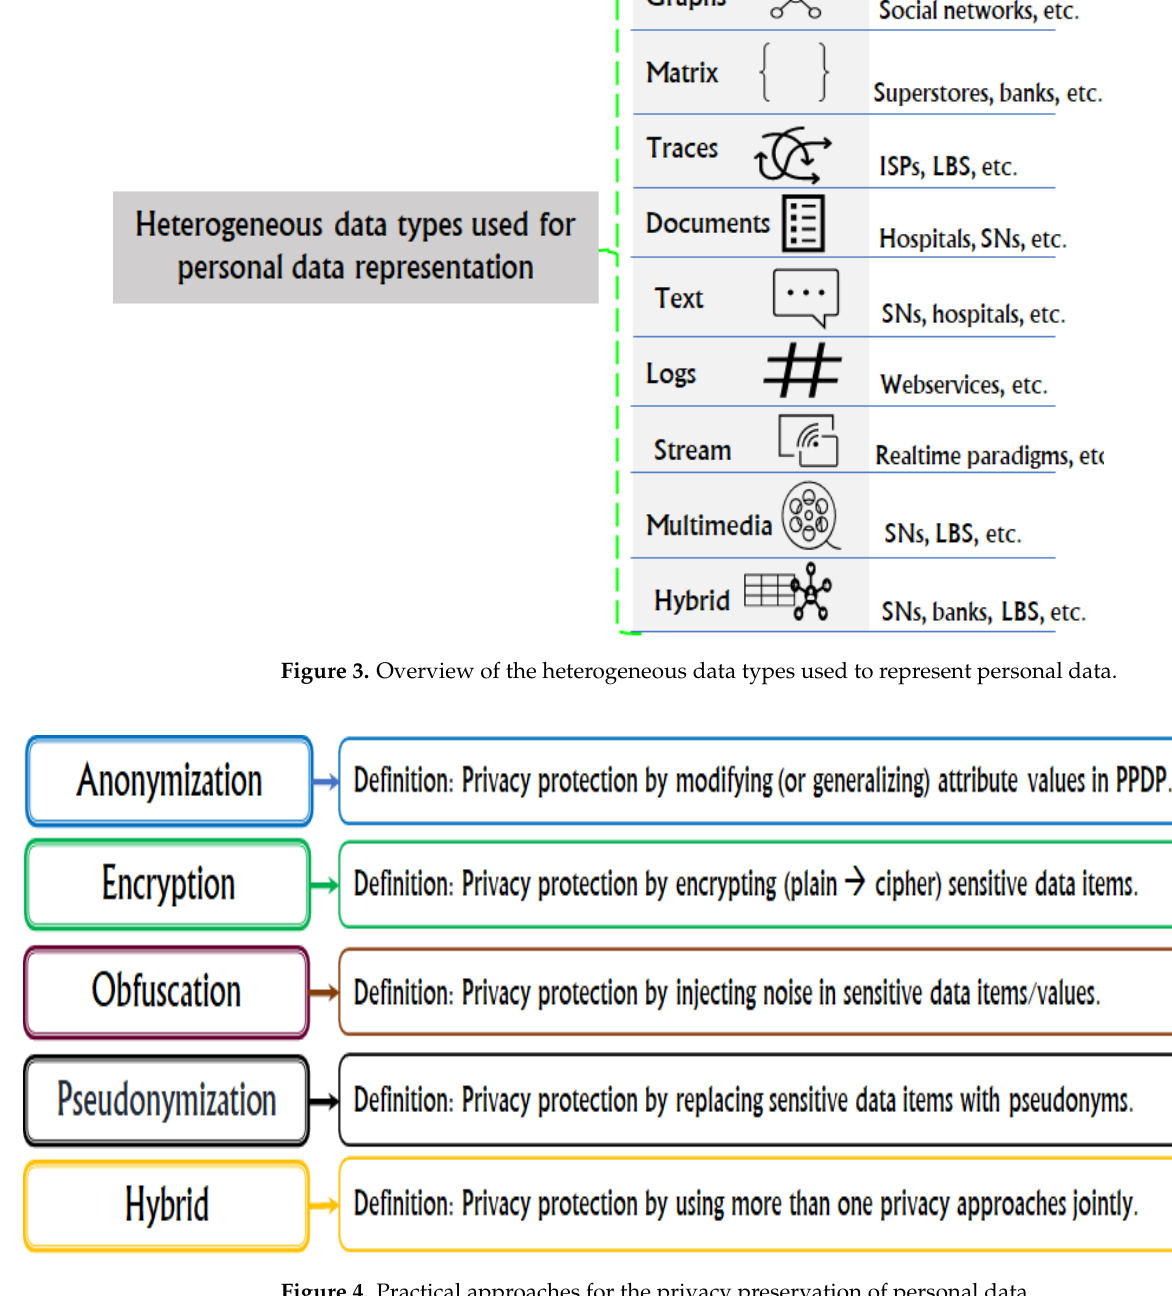
Figure 4. Practical approaches for the privacy preservation of personal